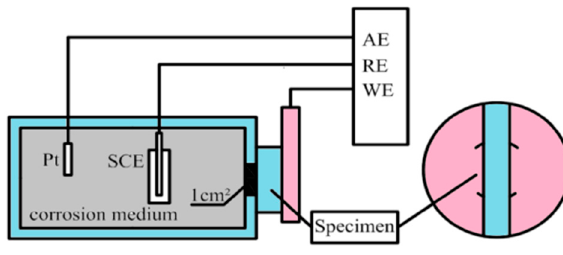
Figure 1. Schematic diagram of the corrosion testing setup.